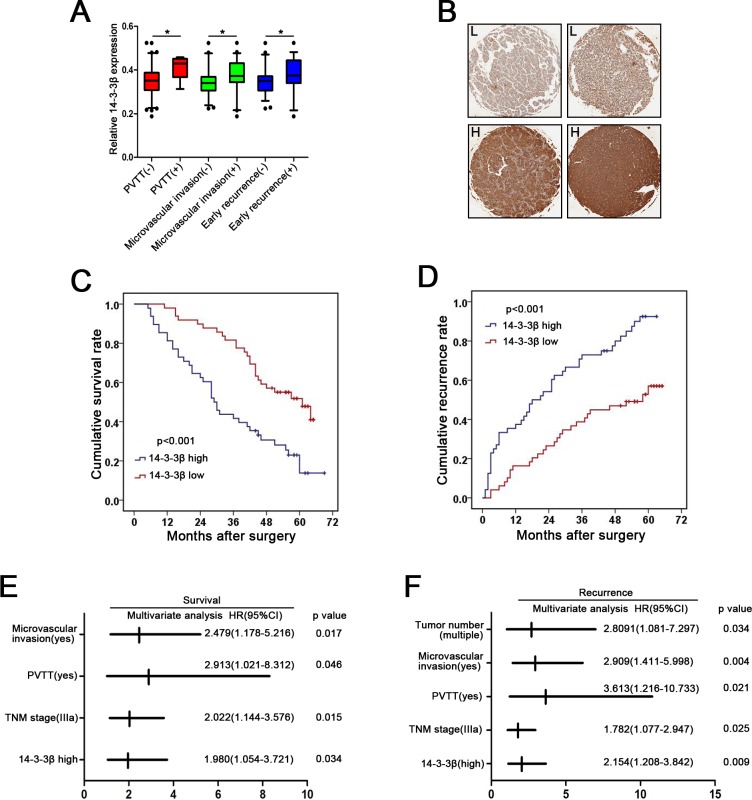
High expression of 14-3-3β in primary HCC tumors is associated with poor survival and high recurrence of HCC patients after surgical resection.(A) Relative expression levels of 14-3-3β in the primary HCC tumors grouped by the presence or absence of different clinical parameters, with the means and 95% confidence intervals. *p<0.05. (B) Immunohistochemical examination of 14-3-3β in primary HCC tumors. H, high; L, low. (C, D) Kaplan-Meier curves of cumulative post-surgical survival and recurrence in HCC patients with high or low level of 14-3-3β. (E, F) Multivariate analysis of parameters associated with the unfavorable post-surgical survival and recurrence. HR, hazard ratio; CI, confidence interval.